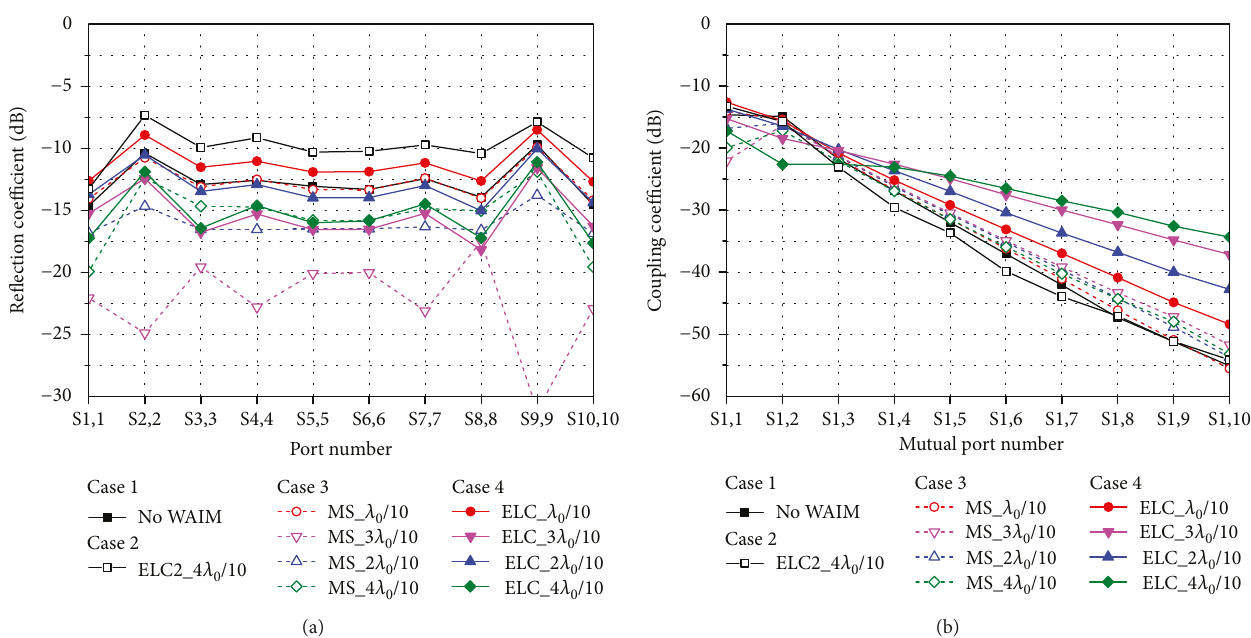
Figure 6: (a) Re fl ection coe ffi cient for each port at 10.0GHz in the four cases. (b) Mutual couplings for port 1 at 10.0GHz in the four cases.